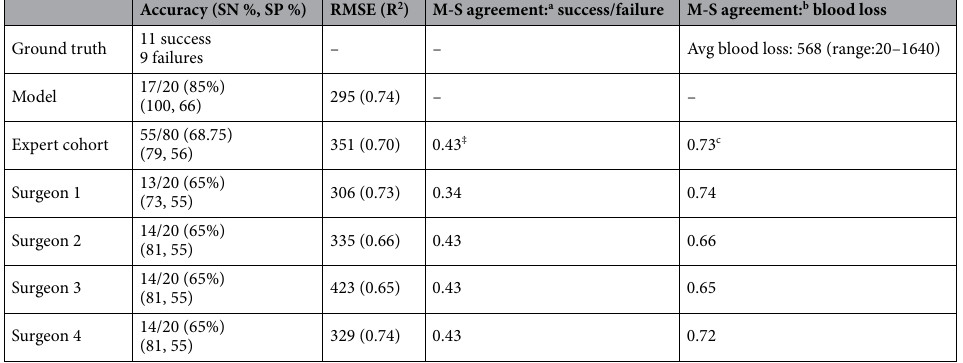
Table 1. Results comparing deep learning model with expert Surgeons. SN: sensitivity; SP: specificity; M-S: model-surgeon. a Kappa coefficient. b Inter-class coefficient. c Inter-Surgeon Agreement: Success/Failure = 0.95, Blood-Loss: